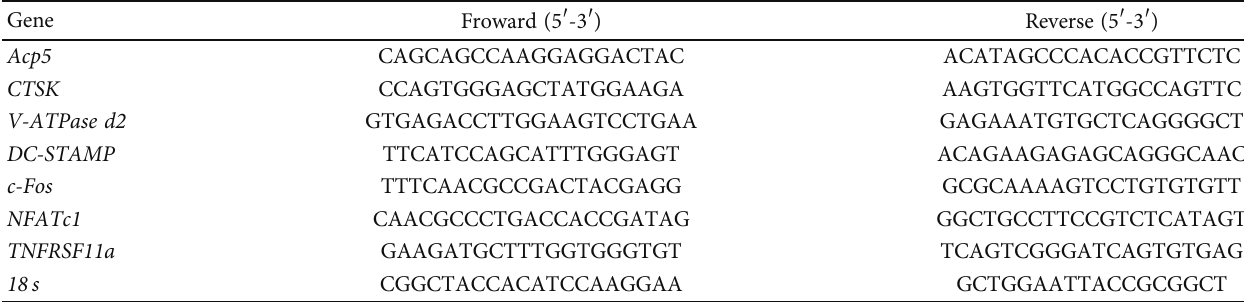
Table 1: Sequences of the primers used for RT-qPCR